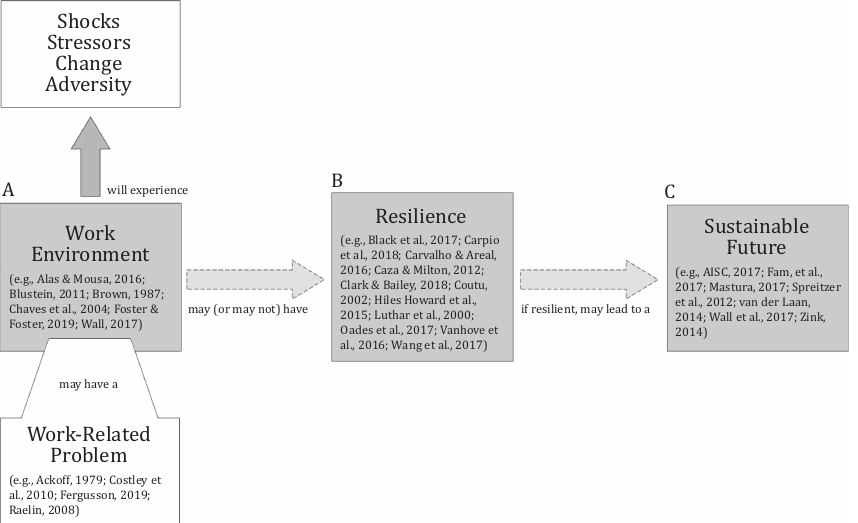
Figure 1. Proto-theoretical